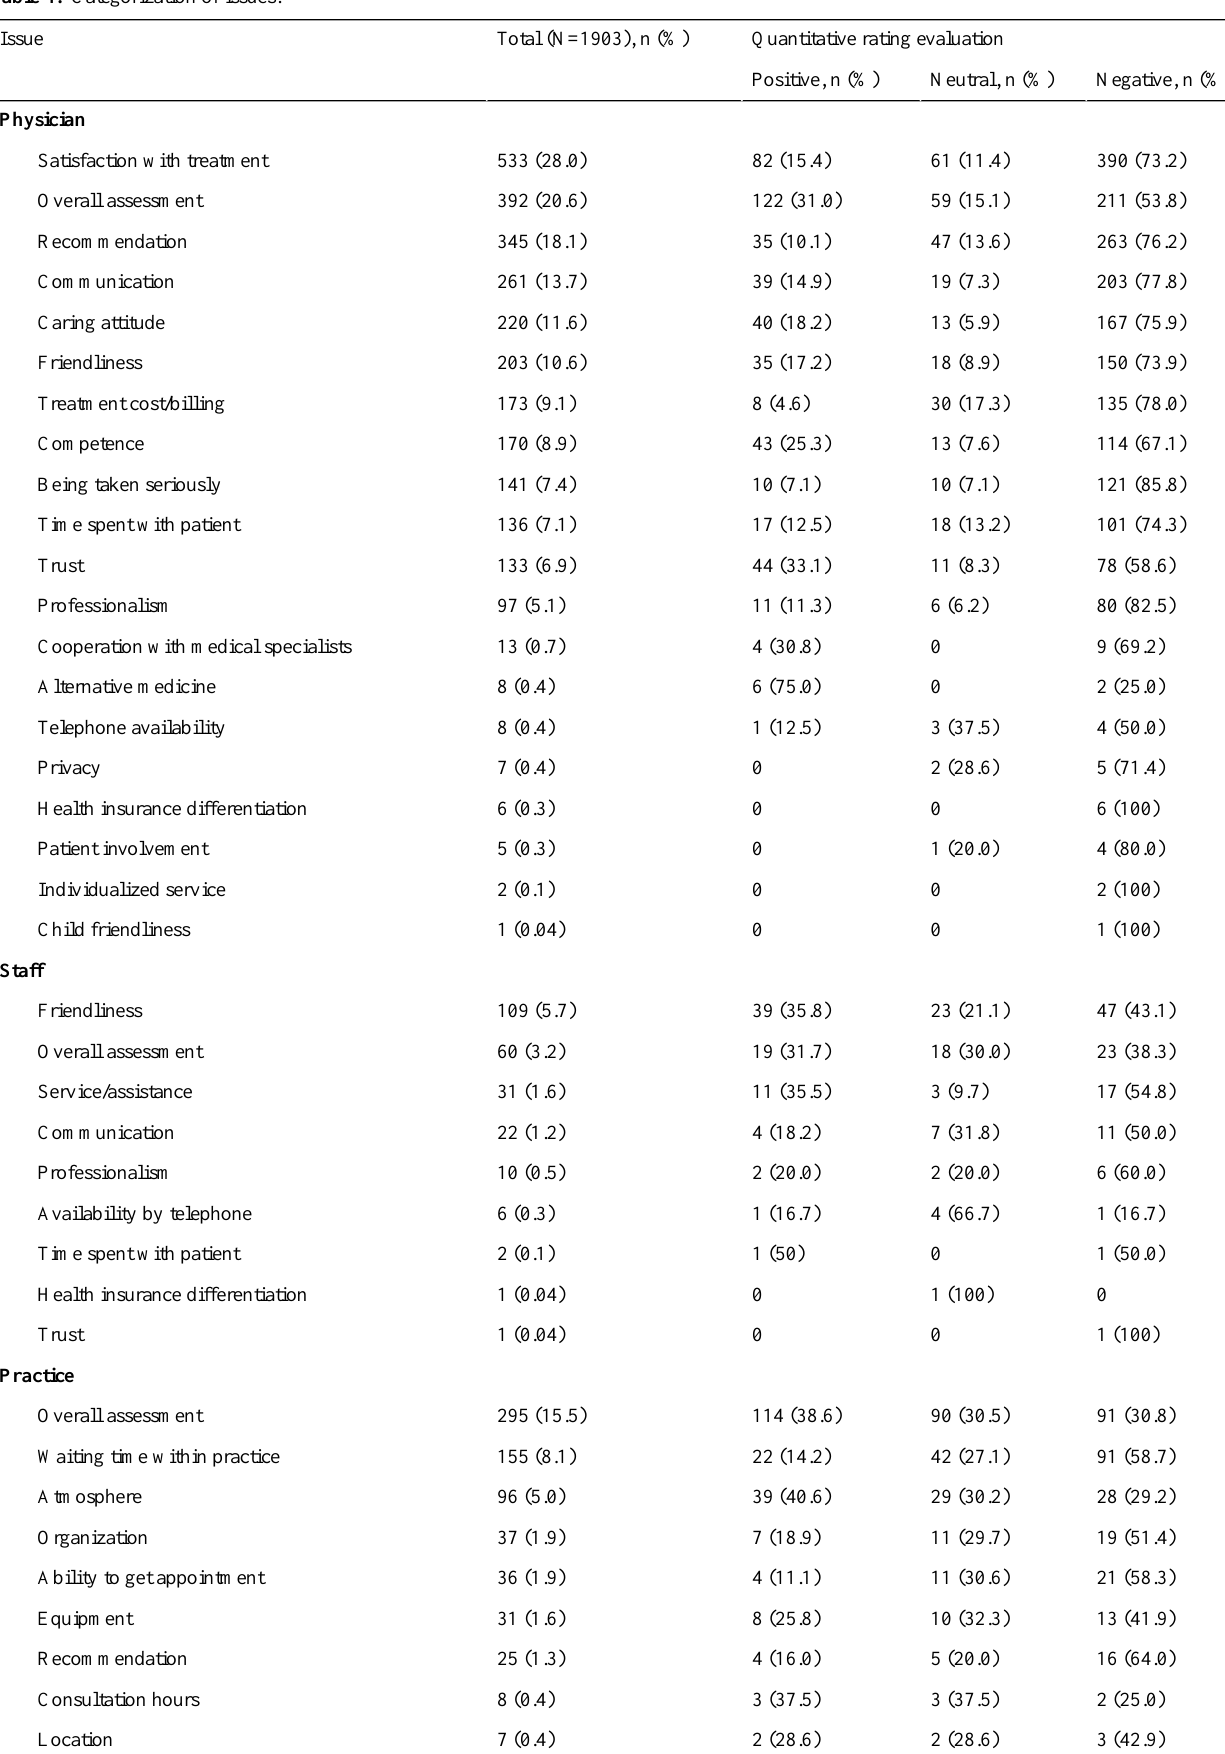
Table 4. Categorization of